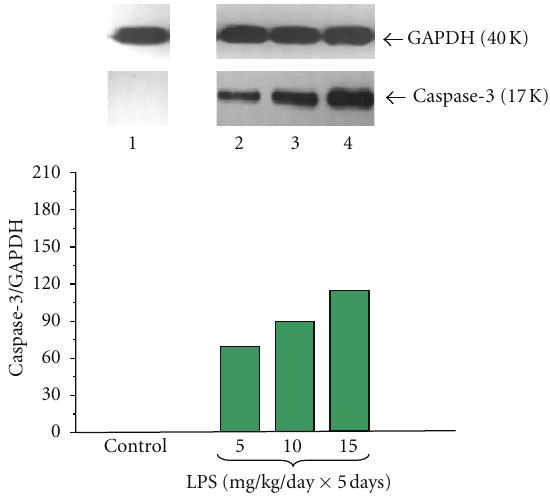
Figure 12: Western blot analysis of apoptosis executioner caspase- 3 protein level in the adult rat pancreatic acinar cells under basal conditions (lane 1), treated in the infant animals by lipopolysac- charide ( Escherichia coli ) at the doses of 5mg/kg/day × 5 days (lane 2), 10mg/kg/day × 5 days (lane 3), and 15mg/kg/day × 5 days (lane 4) after 5 hours of incubation. The blots were stripped and probed with GAPDH to document equal protein loading. All presented results were obtained in 4 consecutive experiments and are representative of the observed phenomenon.